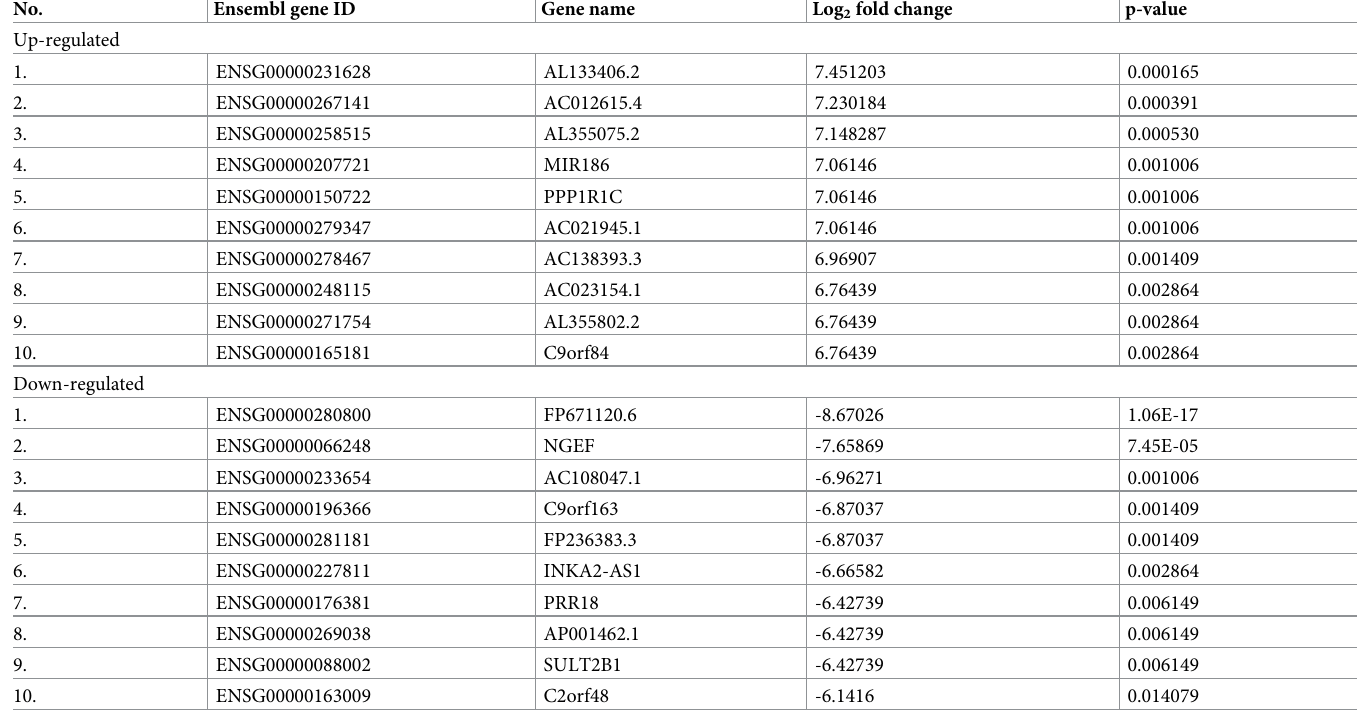
Table 2. Top 10 significant DEGs (up and down-regulated) when comparing the gene expression of MOL-treated hWJMSCs and untreated hWJMSCs (control). Positive log 2 fold change value indicates greater expression on MOL-treated